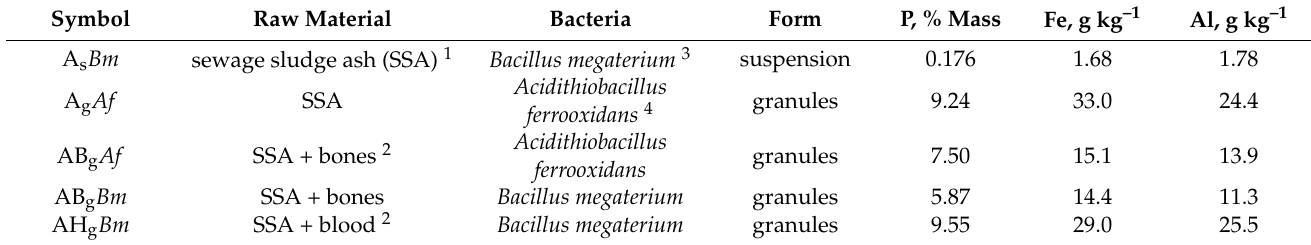
Table 1. Biofertilizers tested in the